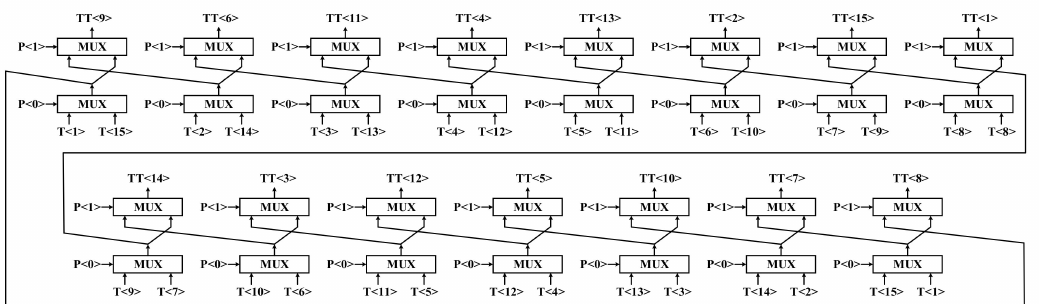
Figure 2. The implementation of the partial randomization dynamic element matching (PRDEM) based on switching sequence optimization.